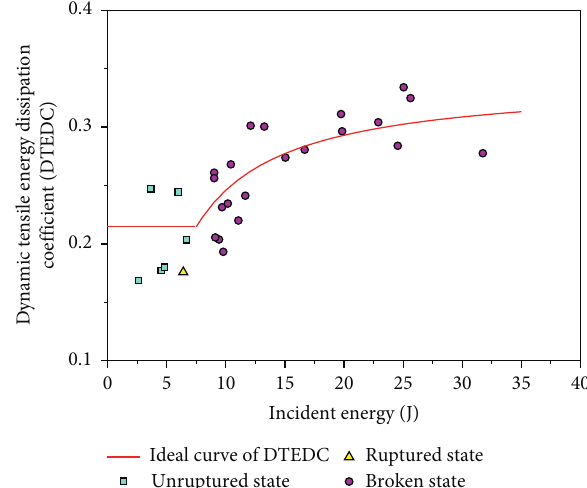
Figure 9: Relation of incident energy versus DTEDC.